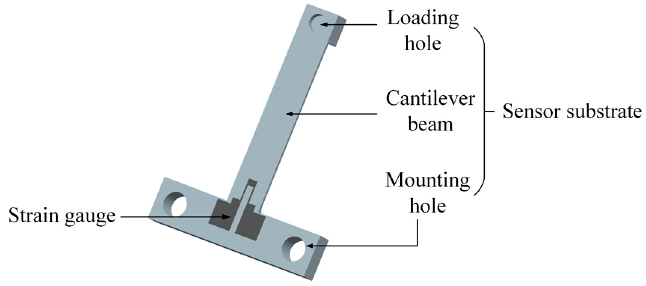
Figure 1. Diagrammatic sketch of the proposed force sensor.